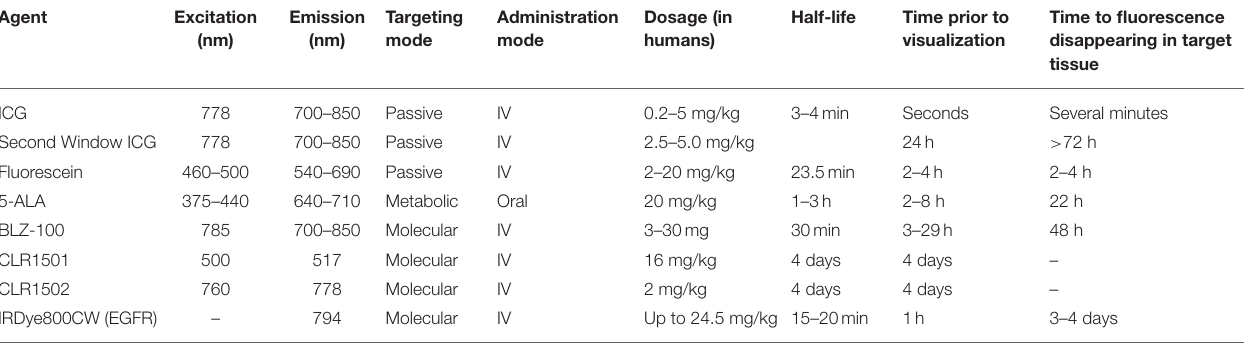
TABLE 1 | Summary of the properties of fluorophores currently used in fluorescence-guided surgery.